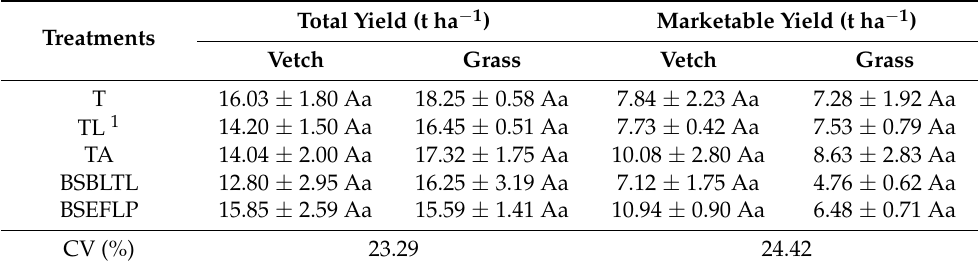
Table 3. Potato tuber yield as a function of organic soil cover and biocontrol agents.